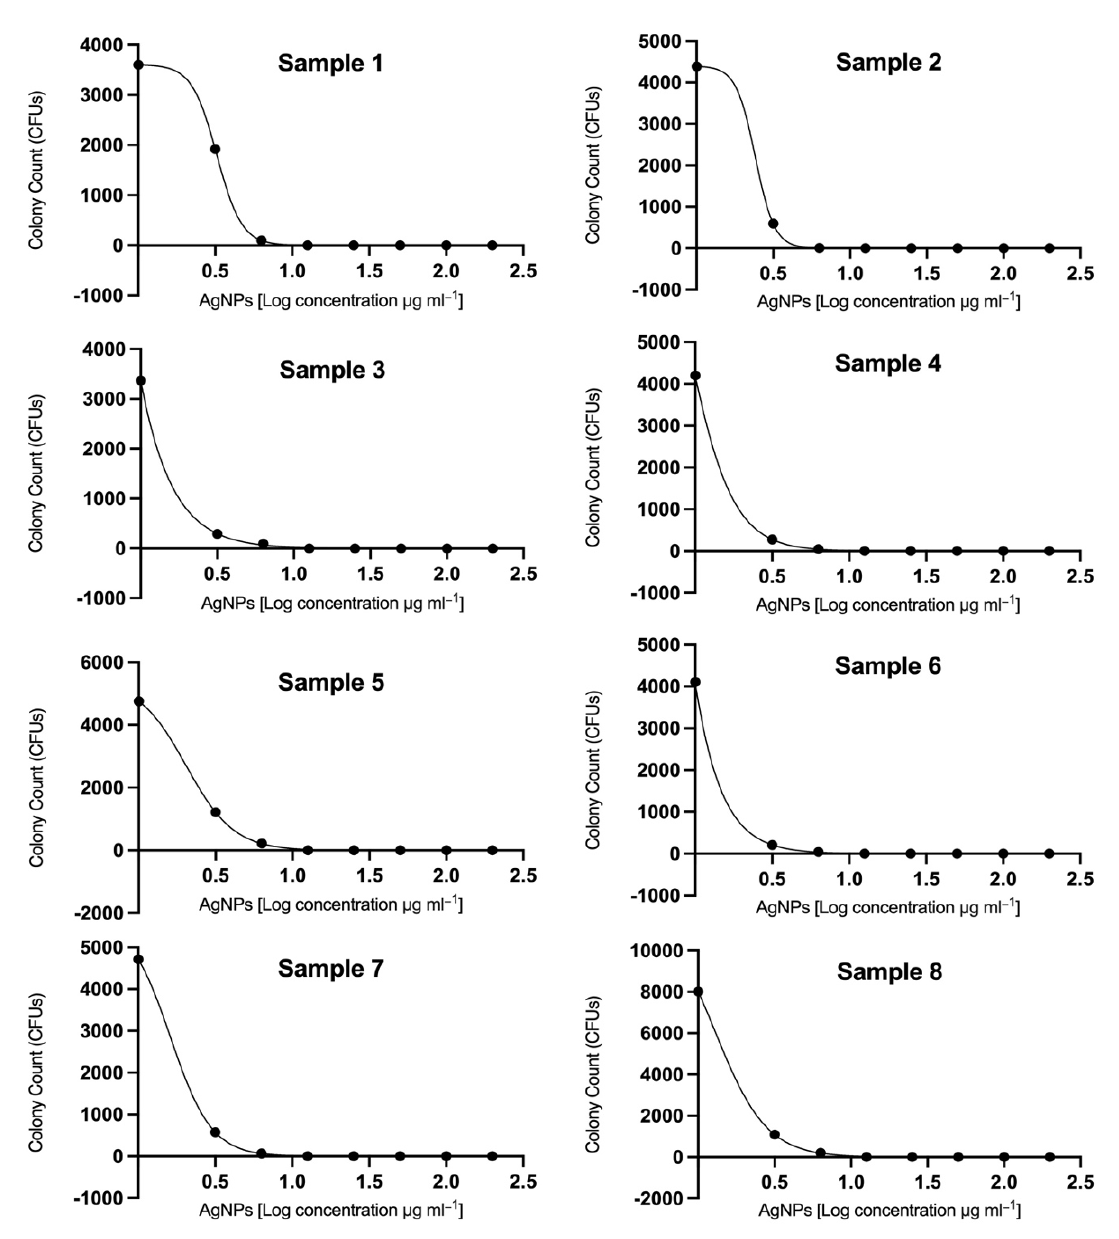
Figure 1. Silver nanoparticles (AgNPs) displayed effective inhibitory activity against eight C. auris clinical isolates. The concentrations of AgNPs ranged from 3.125 to 200 µg mL −1 . The dose–response curves indicate that AgNPs displayed remarkable antibiofilm effects against C. auris isolates. The ranges of calculated IC 50 values were determined from 0.7 to 3.2 µg/mL, where 5 out of 8 strains were less than 2 μg/mL.